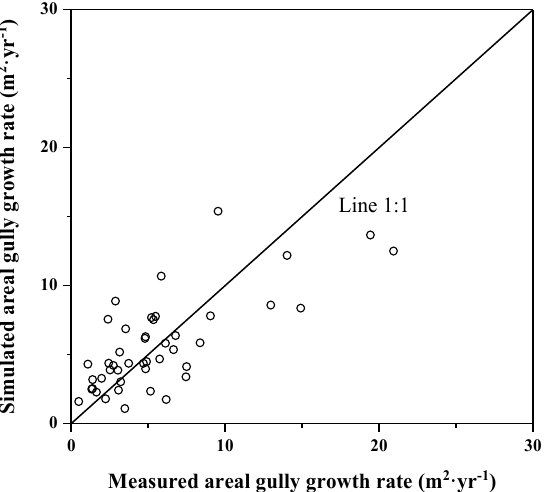
Figure 6. Both the average annual runoff ( Q a , m 3 ·yr − 1 ) and average slope of the drainage area ( S d , m·m − 1 ) were used to fit the annual areal gully growth rate ( R A , m 2 ·yr − 1 ), with an R 2 of 0.530.